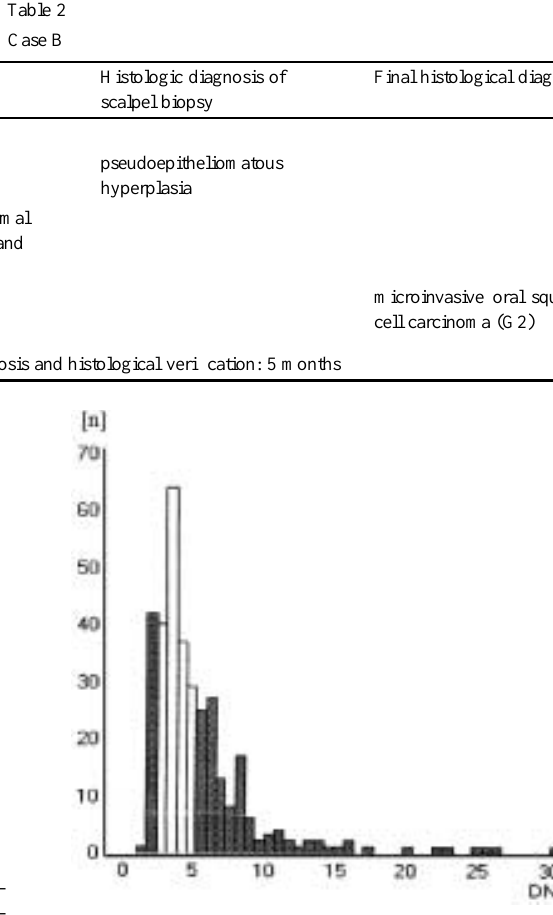
Fig. 7. DNA-histogram of a smear from a squamous cell carci- noma of the arcus palatoglossus (patient C). Different aspects of DNA-aneuploidy can be detected: abnormal stemline at 3.1c and 24 cells greater 9c